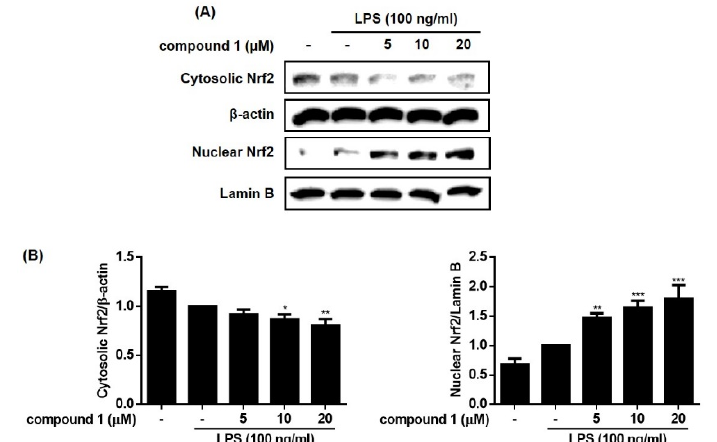
Figure 8. Effects of compound 1 on Nrf2 protein expression in RAW264.7cells. The RAW264.7 cells were pretreated with the compound (5, 10, and 20 µ M) for 1h before exposure to LPS for 24 h. Protein samples for nuclear and cytosol extract of RAW264.7 cells were analyzed by Western blot using anti-Nrf2 antibody. The representative blots ( A ) and the calculated intensities ( B ) after normalization to Lamin B (nucleus) or β -actin (cytosol) were presented. Results are presented as the mean ± standard deviation from three independent experiments. The results differ significantly from LPS-only treated; * p < 0.05, ** p < 0.01, and *** p < 0.001.